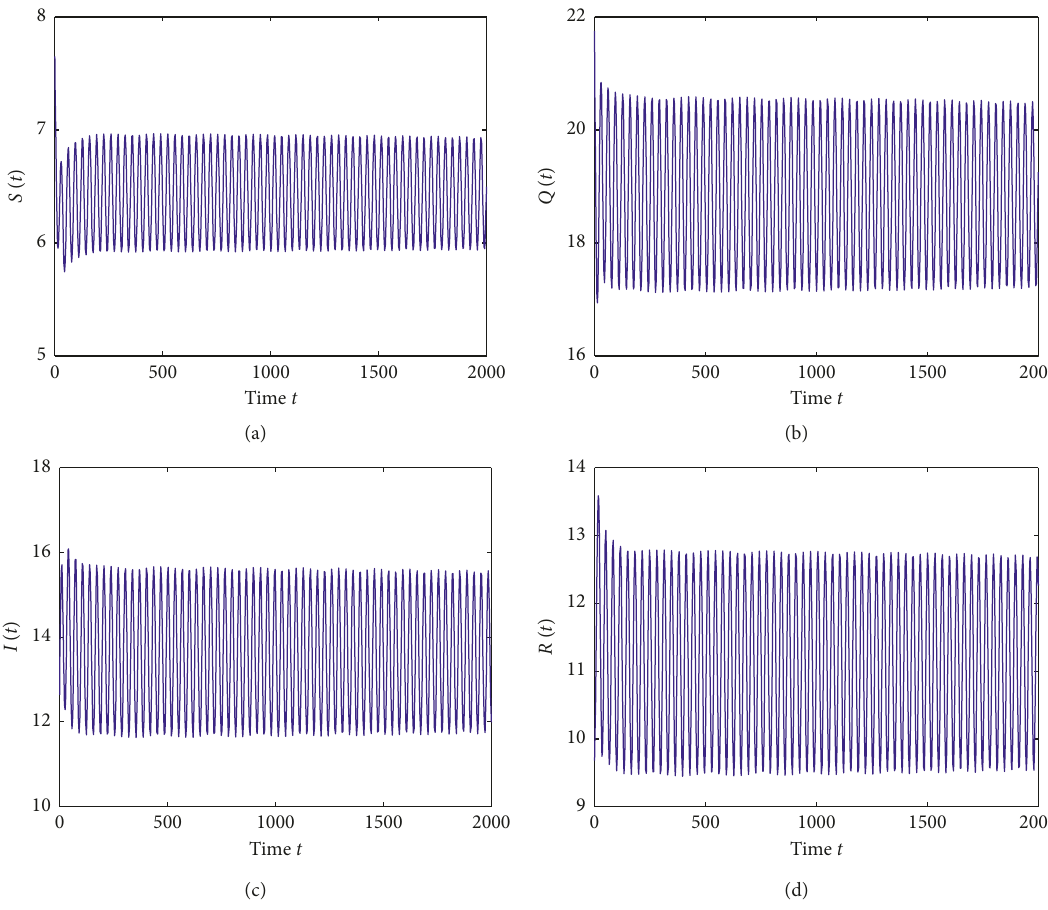
Figure 9: Waveform plots of system (65) with τ � 11 . 3691 > τ